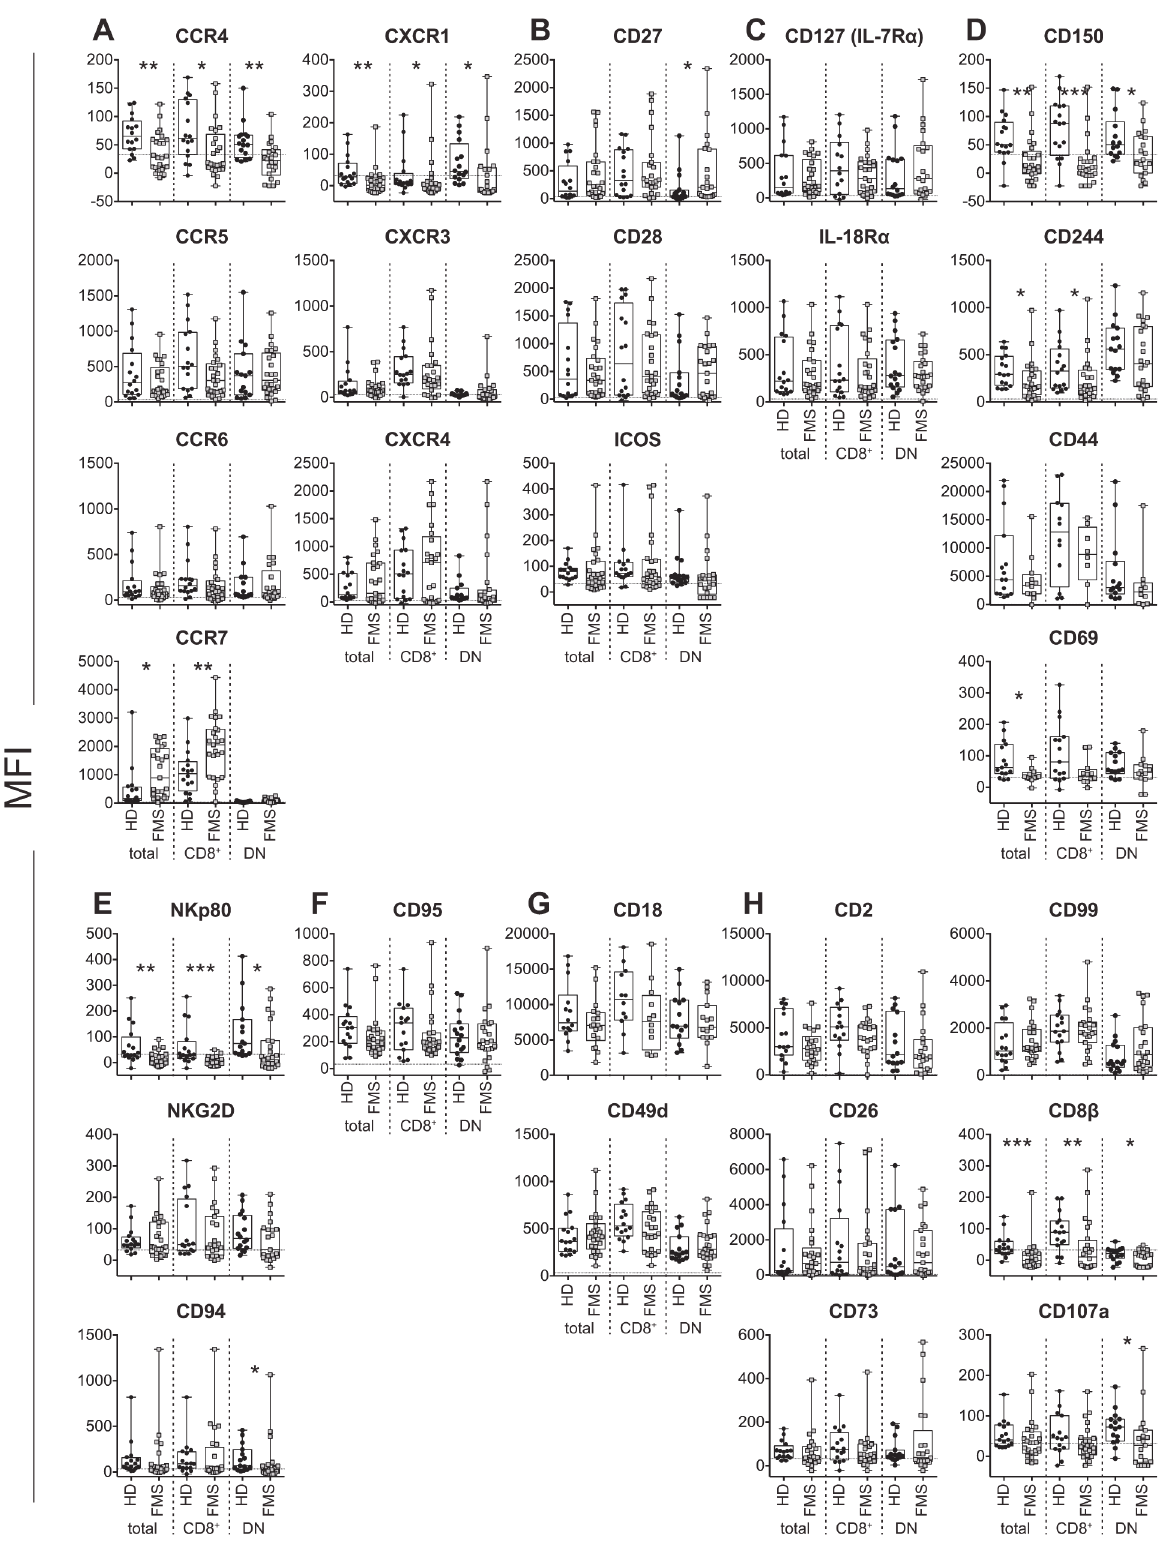
Fig 2. Comparison of the cell surface antigen expression level in MAIT cells between HD and FMS. A, Chemokine receptor expression in total, CD8 + , and DN MAIT cells. B, Co-stimulatory molecule expression in total, CD8 + , and DN MAIT cells. C, Cytokine receptor expression in total, CD8 + , and DN MAIT